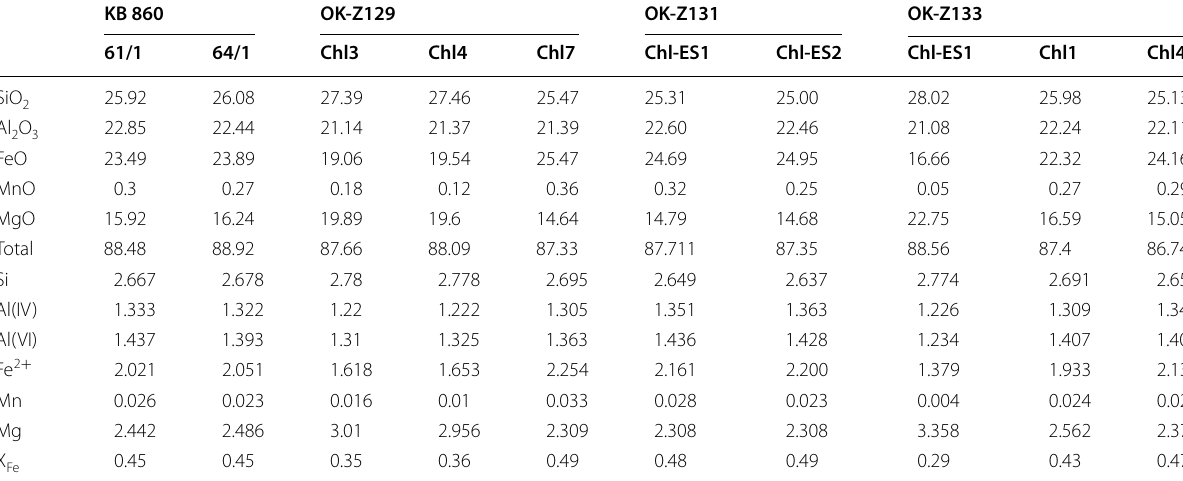
Traces of Ti, Cr, Ca, Na and K (all < 0.1 wt%), concentrations in wt%, formulas per 14